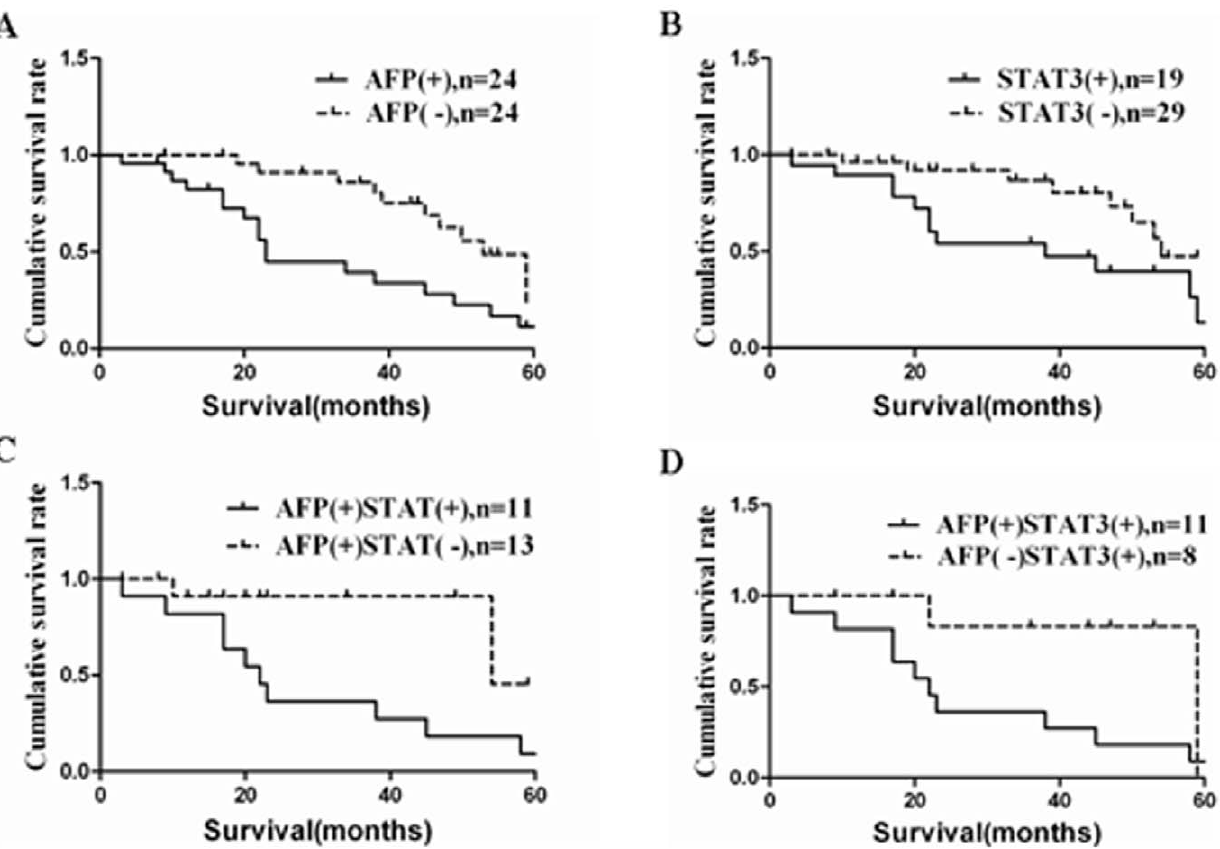
Figure 6. Kaplan–Meier survival curves and log-rank test for patients with AFP-positive gastric cancer (AFPGC) stratified by AFP and STAT3 expression. ( A ) AFP positivity alone. ( B ) STAT3 positivity alone. ( C ) AFP and STAT3 double positivity compared with AFP positivity. ( D ) AFP and STAT3 double positivity compared with STAT3 positivity(all P , 0.05).